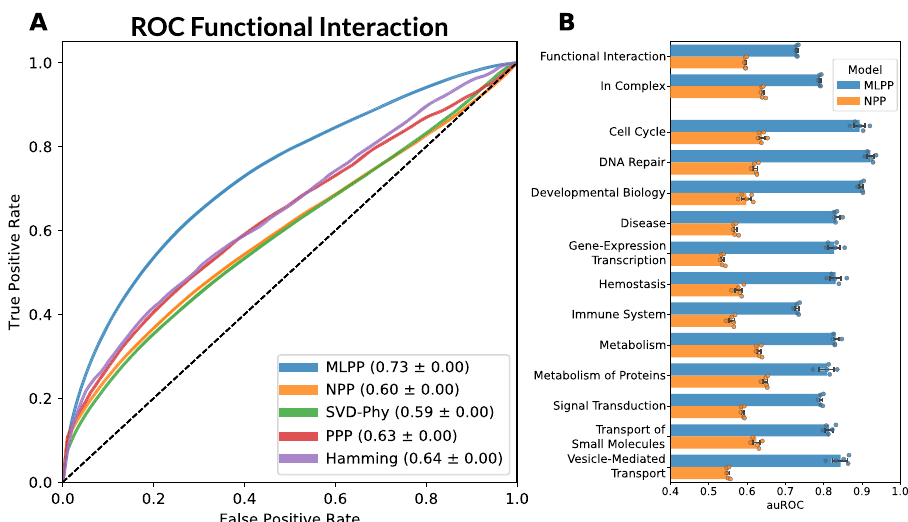
Fig. 1 Method comparison for prediction of functional interactions. Our model (MLPP) was compared against other phylogenetic pro fi ling approaches in terms of the receiver operator curve (ROC) and area under the curve (AUC) in predicting pairs of functionally interacting genes. Additionally, MLPP could predict the interaction context - complex co-occurrence, or one of 12 top-level pathways from Reactome. The model outperformed other approaches in predicting functional interaction ( A , B ) and the interaction context ( B ) when compared in 5-times cross-validation. Error bars denote the 95% con fi dence intervals using 1000 bootstrap samples. MLPP — machine-learning phylogenetic pro fi ling, NPP — normalized phylogenetic pro fi ling, SVD-Phy — singular value decomposition phylogenetic pro fi ling, PPP — PrePhyloPro, Hamming — binarized phylogenetic pro fi ling with Hamming distance. Source data are provided as a Source Data fi le.